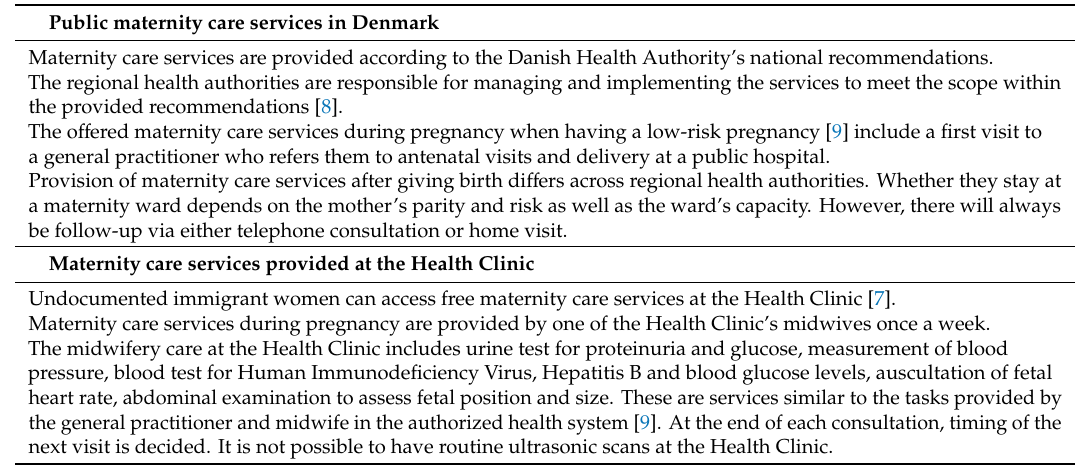
Table 1. Public maternity care services in Denmark and maternity care services provided at the Health Clinic. Public maternity care services in